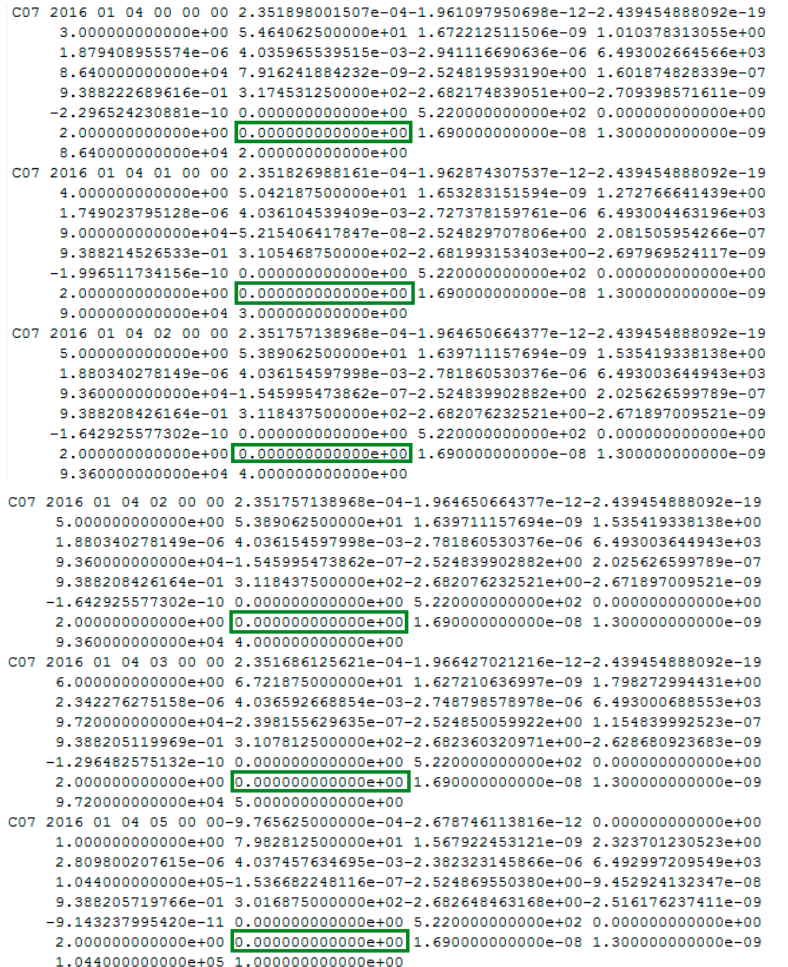
Figure 13. The bias of XMIS between pseudo-range SPP coordinates and the SINEX coordinates on doy 004, 2016.